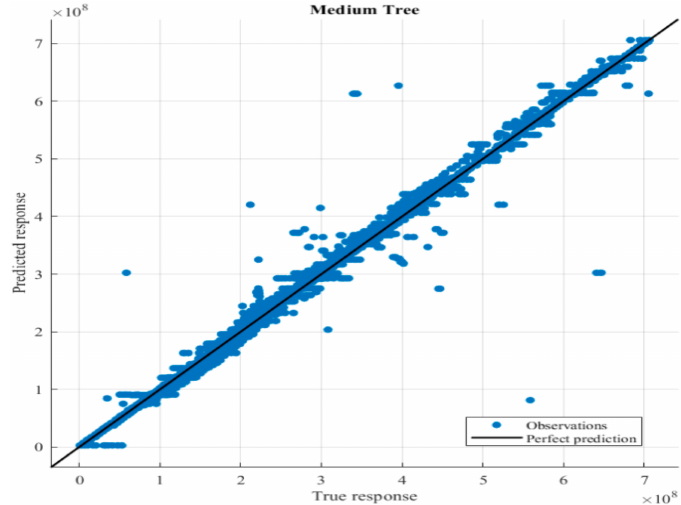
Figure 14. Medium Trees Prediction vs. Actual testing.